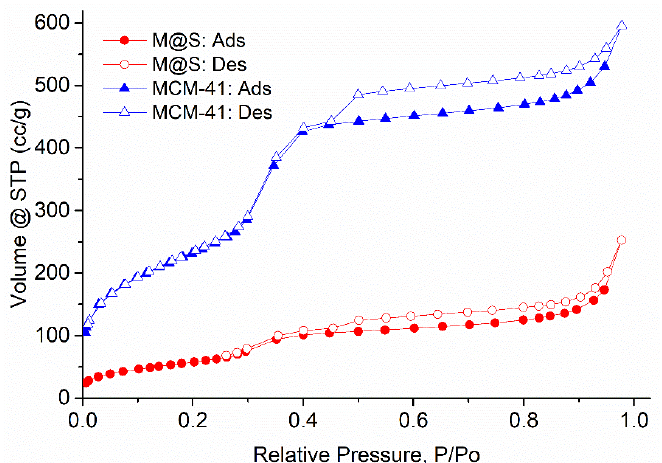
Figure 2. N 2 physic-sorption isotherms of M@S and MCM-41.